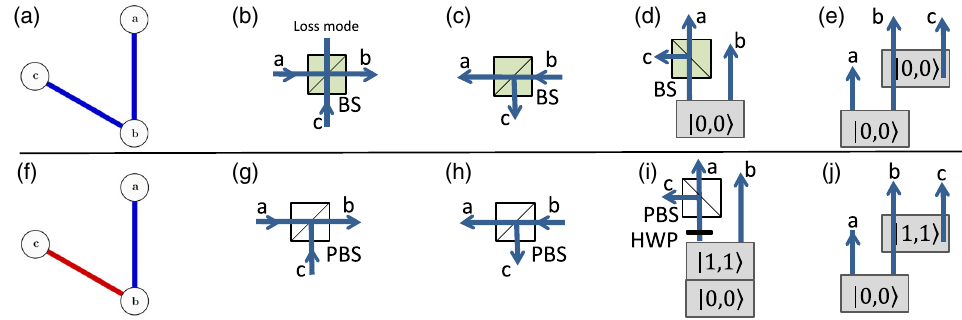
FIG. 8. Merging edges of graphs. Edges can be merged at one vertex in several different ways. (a) If the edges have the same color, the corresponding photons have the same mode number. (b) – (d) In that case, the edges can be merged with probabilistic beam splitters (green squares) or by creating them directly with path identified photon-pair sources [for instance, SPDC crystals; see (e)]. (f) If the edges have different colors, the corresponding photons have different mode numbers. In that case, the edges can be merged losslessly with mode-dependent beam splitters (so-called multiplexing or demultiplexing); white squares, for example, polarizing beam splitters if the degree of freedom is photonic polarization [see (g) – (i)]. (j) The edges could also be created by path identified photon-pair sources (for instance, SPDC crystals). Other probabilistic photon sources, such as lasers as probabilistic single-photon sources, can be added by exploiting hypergraph structures